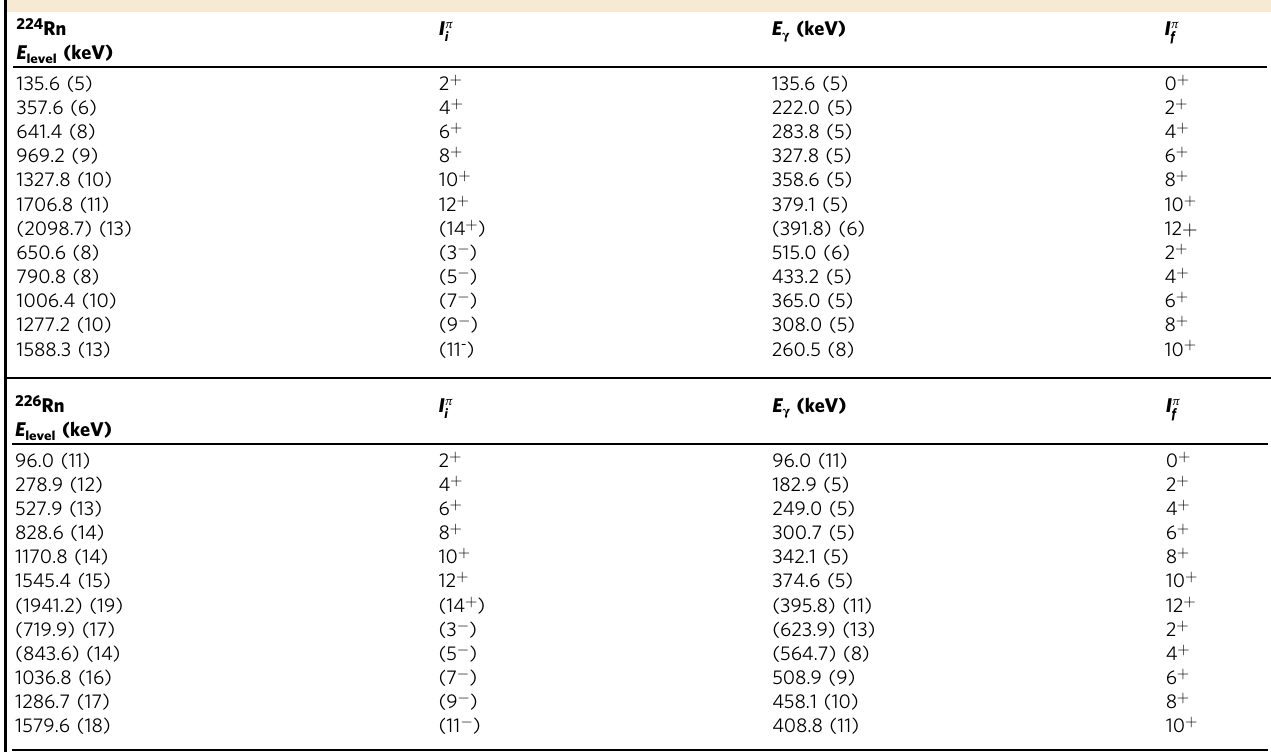
Table 1 Energies of levels and transitions in 224 Rn and 226